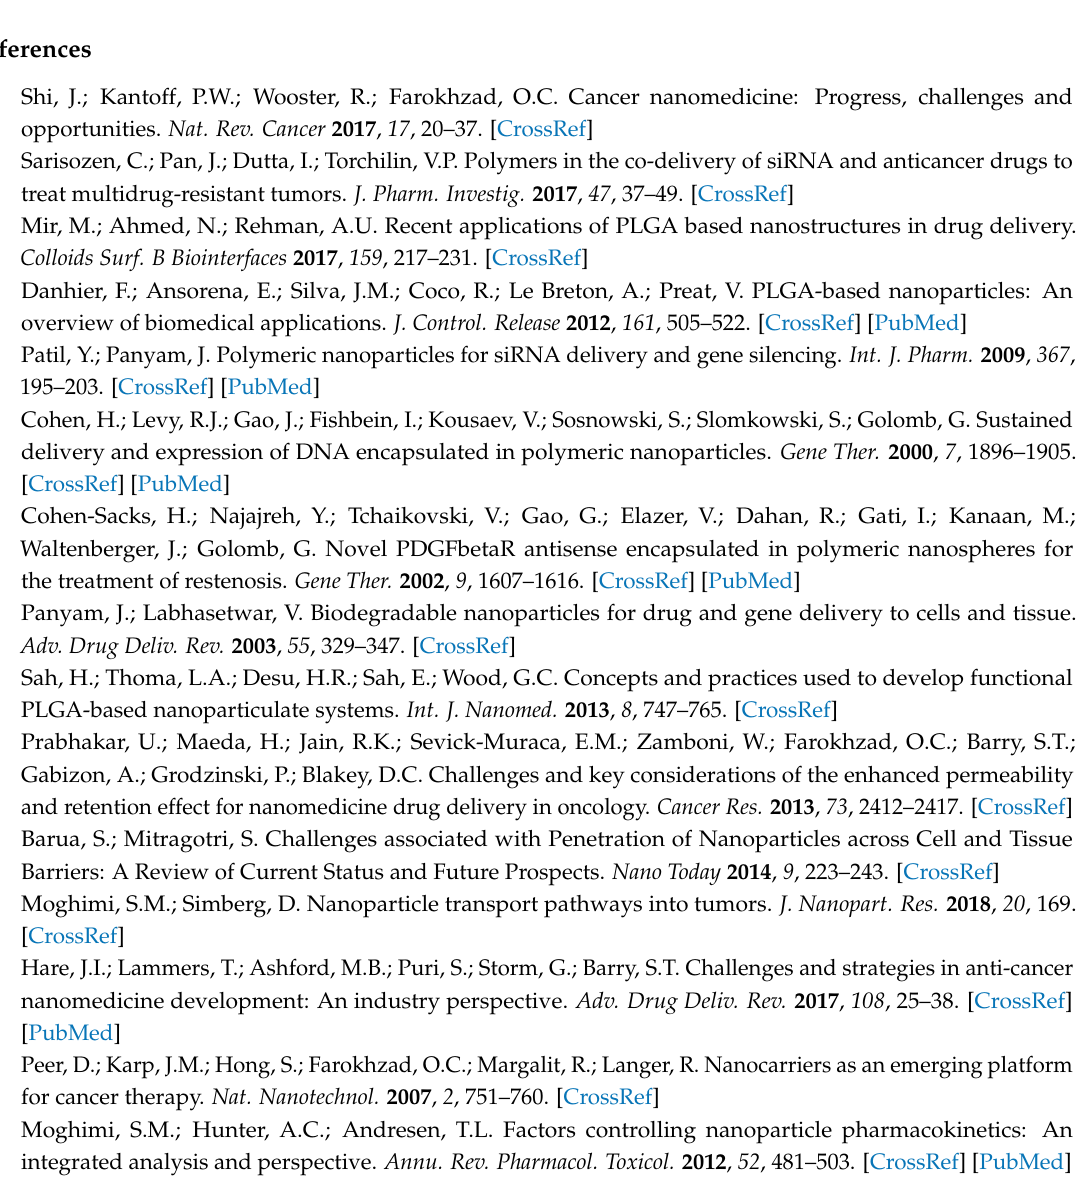
Figure S1: Confirmation of amine-PEG-maleimide (NH2-PEG-MAL) conjugation to PLGA by 1H-NMR analysis, Figure S2: Temperature-dependent uptake of targeted and non-targeted NPs by MDA-MB-231 cell line, Figure S3: A representative image of the metastatic lungs in the 4T1 IV model, Figure S4: NPs uptake by circulating WBC and monocytes, examined in the 4T1 IV model and in the orthotopic xenograft model, Figure S5: Cellular uptake of NPs by MDA-MB-231 cell